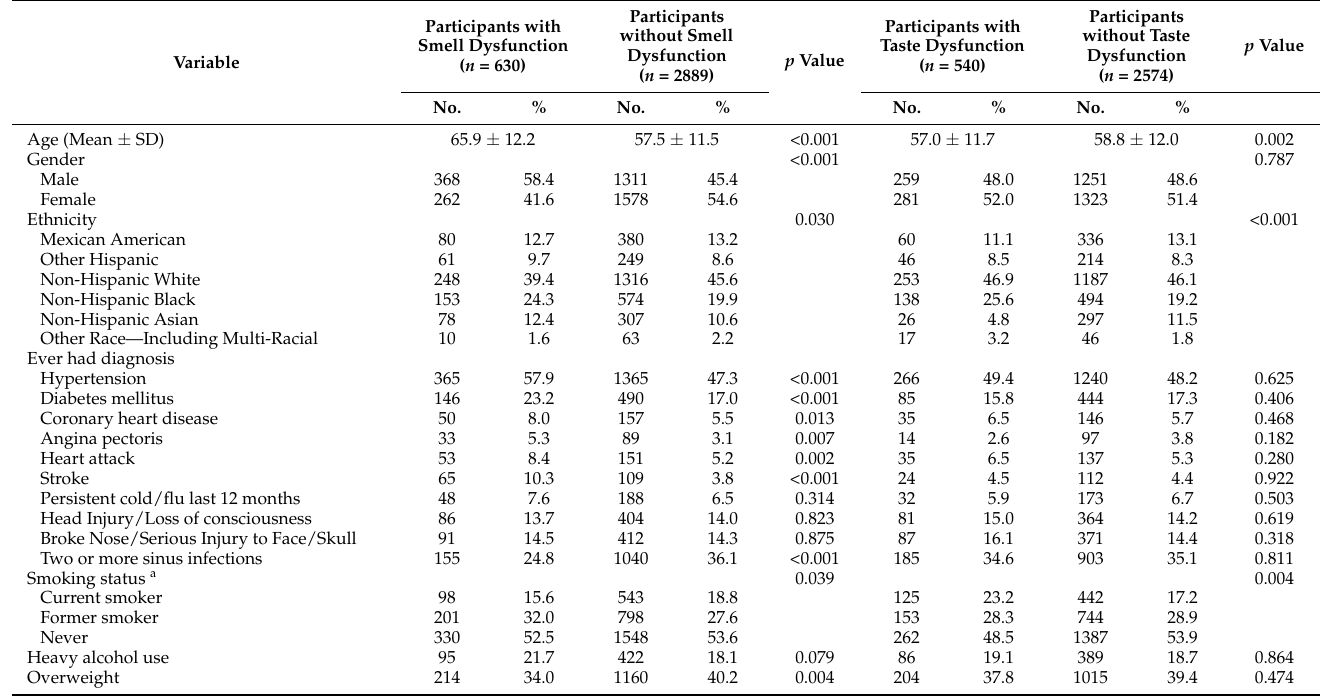
Table 1. Baseline characteristics based on smell and taste dysfunction among study